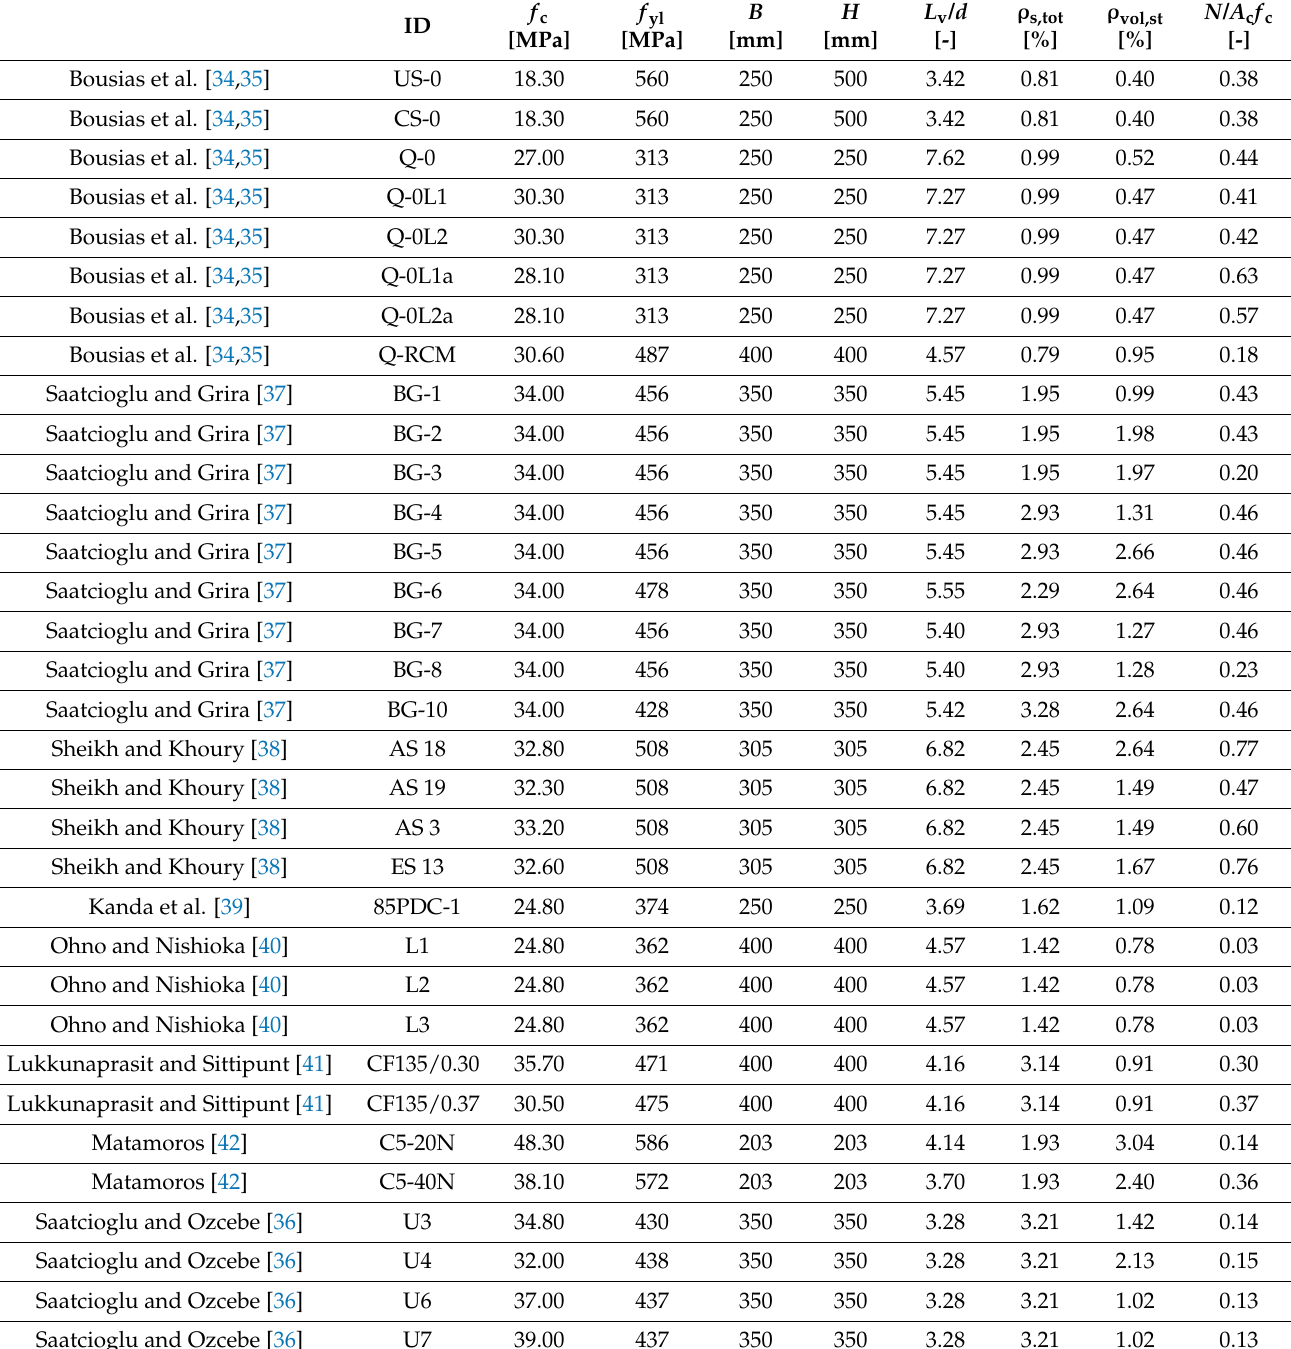
Table 1. Main geometric and mechanical characteristics of the selected